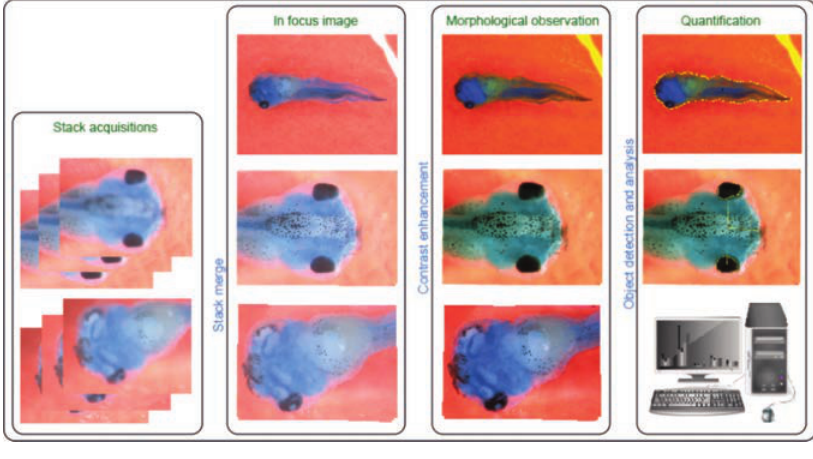
Figure 1. Logical scheme of image improvement and analysis for biometric criteria quan- tification. Morphological observation results in binary information such as spinal cord or organs integrity, while objects detection and segmentation provides quantitative bio- metrical description of each tadpole.